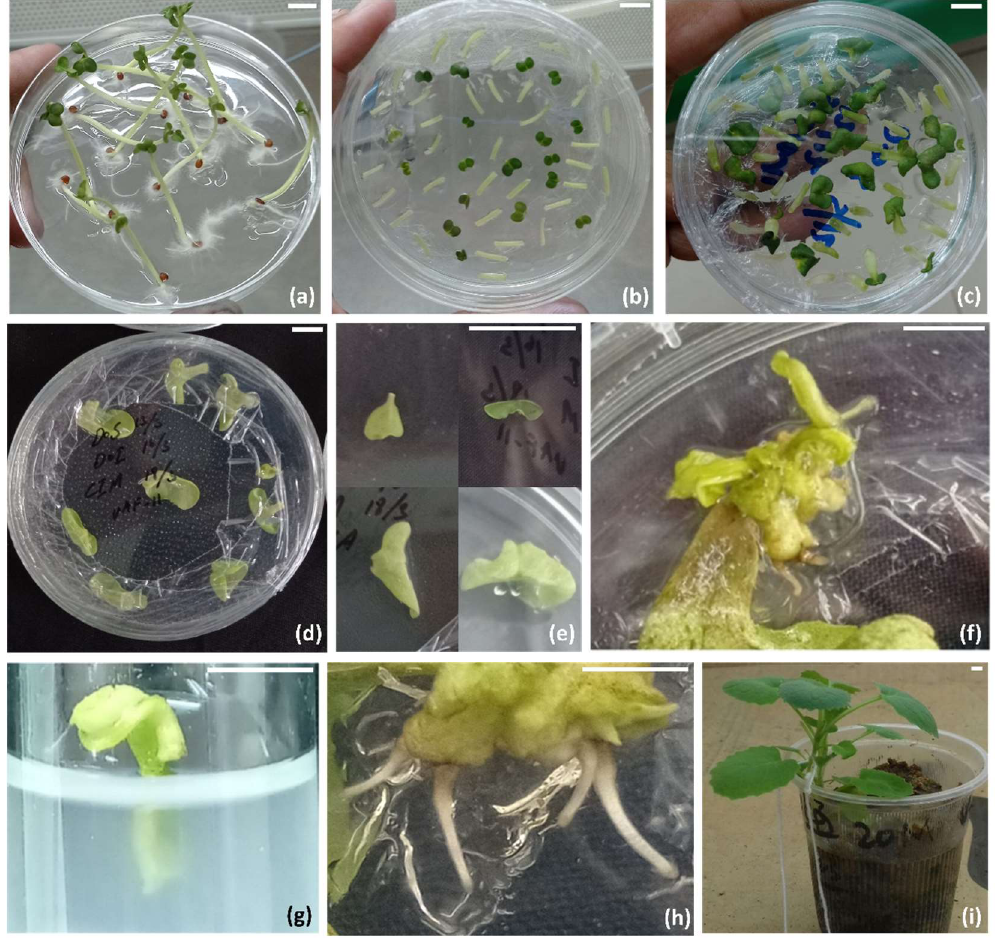
Figure 1. Regeneration and acclimatization of UAF11 and Toria. ( a ) In-vitro grown seedlings of UAF11 and Toria, ( b ) excised cotyledonary leaves and hypocotyls on cocultivation medium, ( c ) explants on the callus induction medium, ( d ) cotyledons on regeneration media, ( e ) progressive increase in the swelling of the cotyledons after Agrobacterium cocultivation, ( f ) regenerated cotyledons, ( g ) regenerated shoots on rooting medium, ( h ) rooting initiation, and ( i ) acclimatization of the in vitro plants (Bars = 1